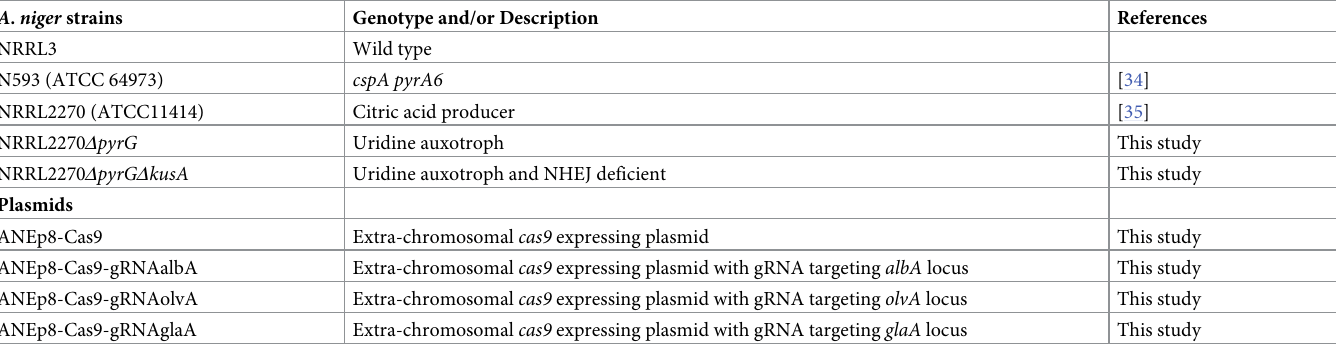
Table 2. Strains and plasmids used in this